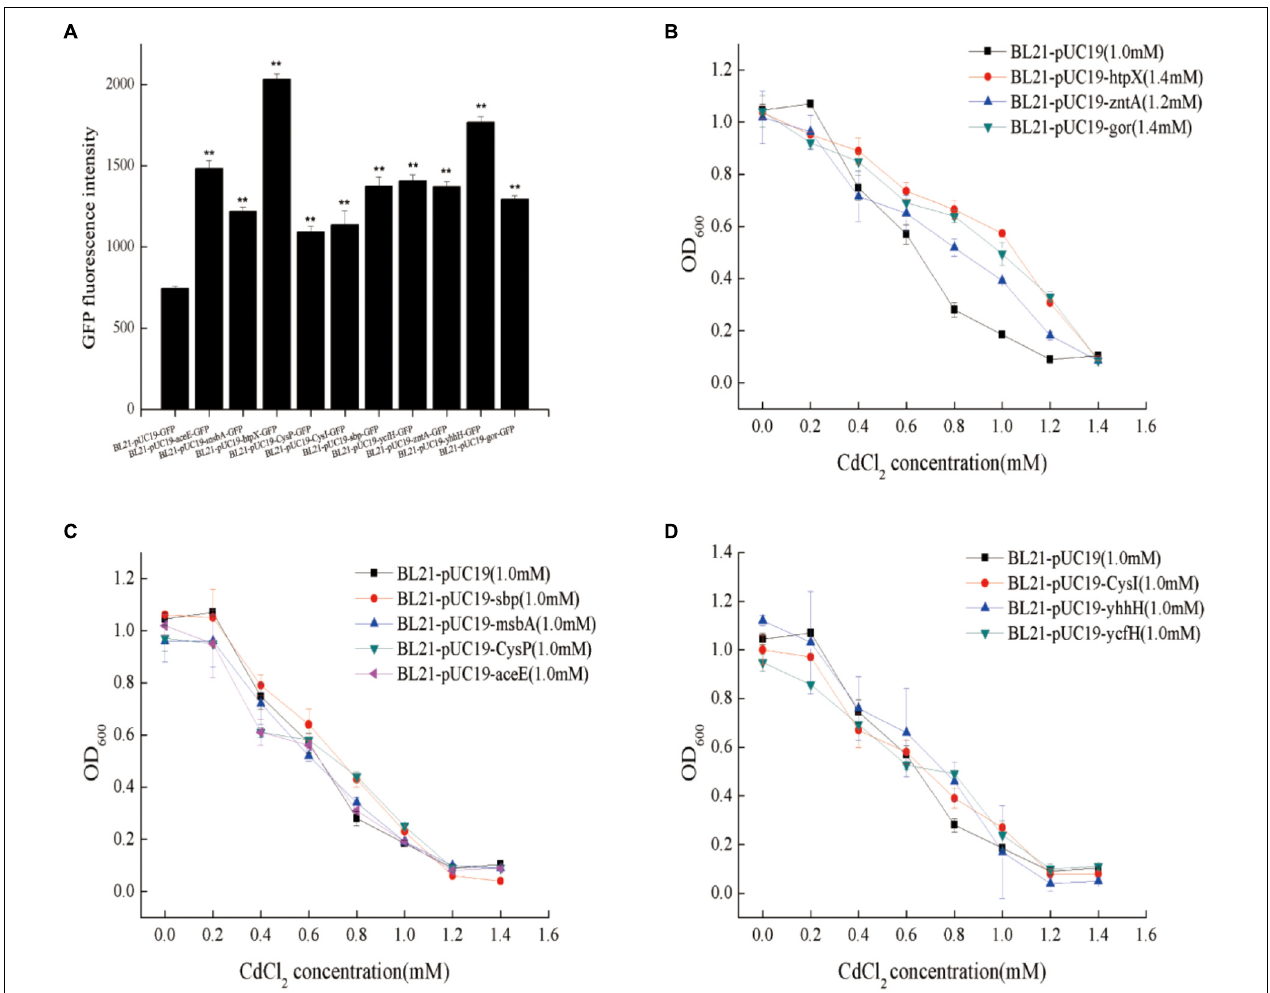
FIGURE 4 | Fluorescence intensity and cadmium resistance capacity of gene-overexpressing strains. (A) BL21-pUC19-aceE-GFP and BL21-pUC19-sbp-GFP represent the overexpression of aceE and sbp , respectively, with BL21-pUC19-GFP as a negative control. (B–D) BL21-pUC19 was used as a control; ∗∗ p < 0.01. 1.0 and 1.2 mM represent the cadmium MIC